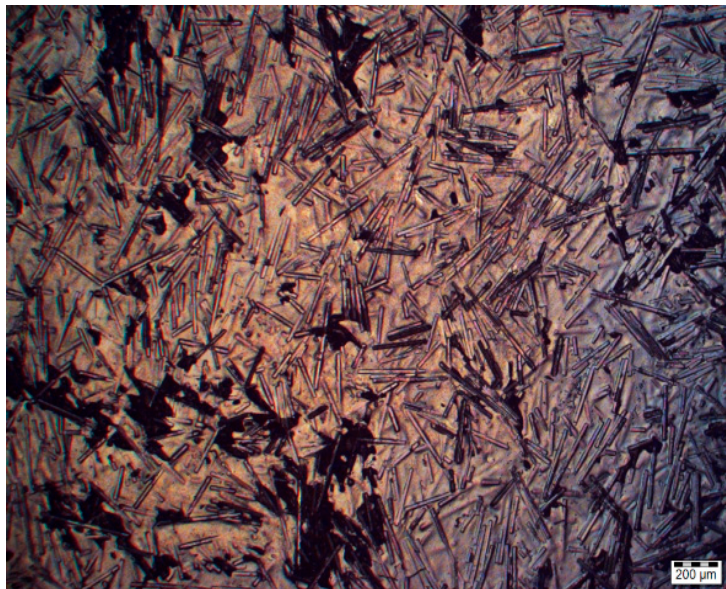
Figure 12. An example image of lightly pressed paraffin wax-based feedstock with 50 vol % of fibers in solid content for measuring the fiber length.